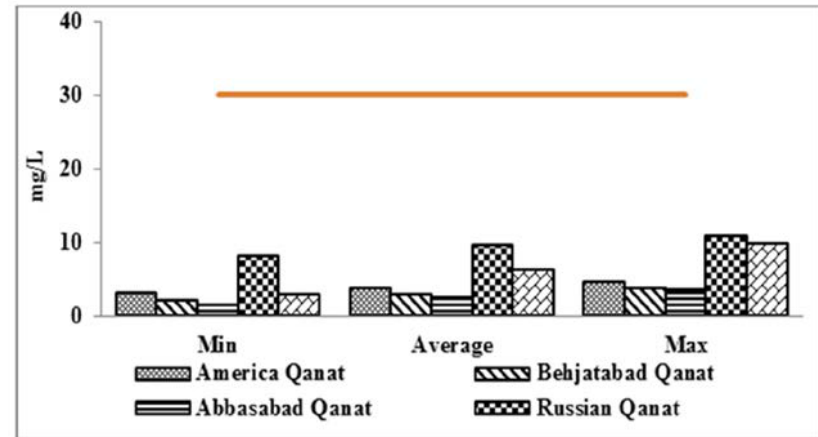
Fig. 16: The measured BOD level of the studied aqueducts